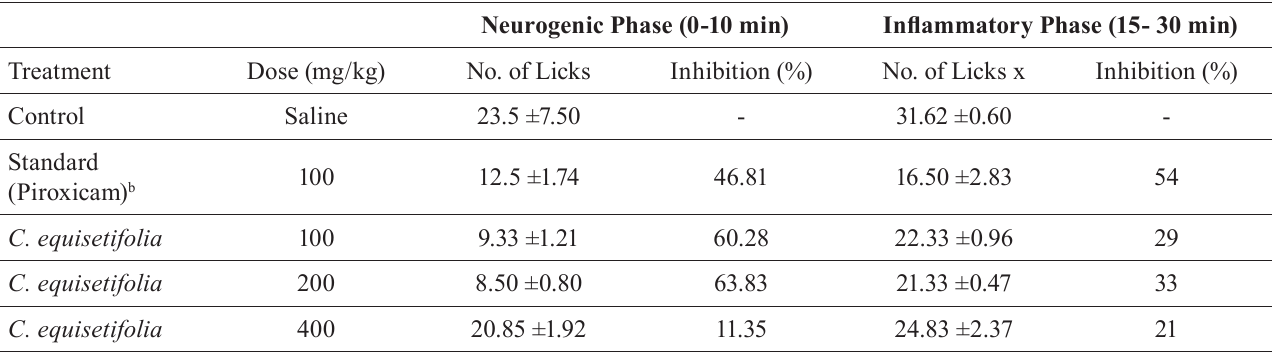
TABLE II - Formalin induced pain anti-nociceptive effect of oral treatment with C. equisetifolia essential oil